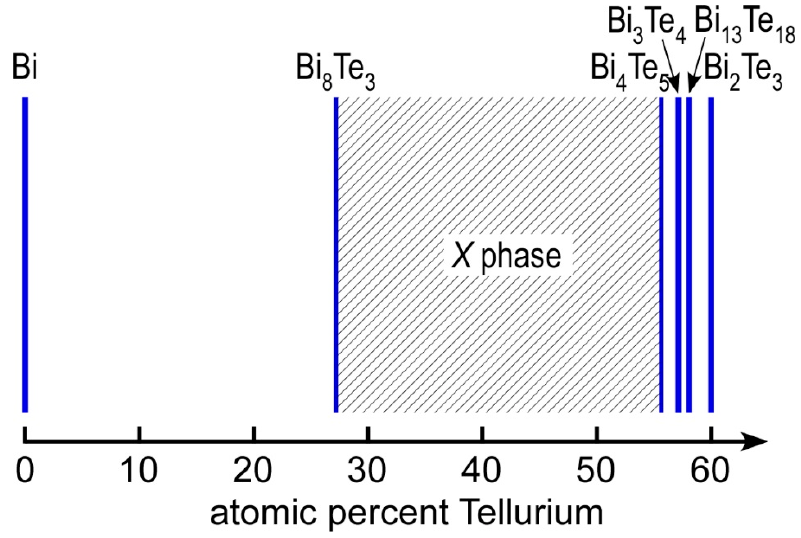
Figure 7. The X phase composition region in the Bi–Te binary system.